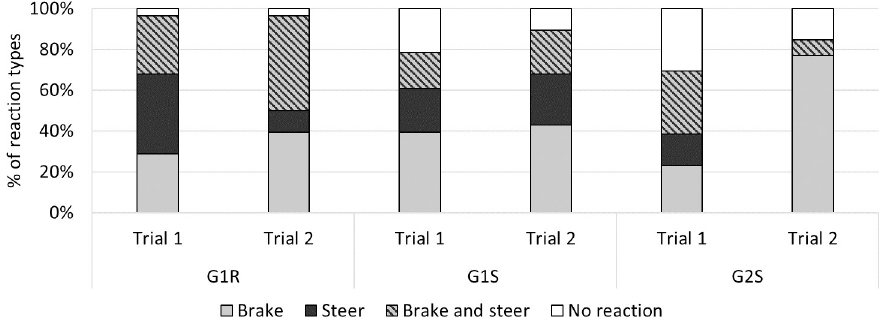
Fig 7. Driving behavior observed in response to the ball crossing the road in front of the